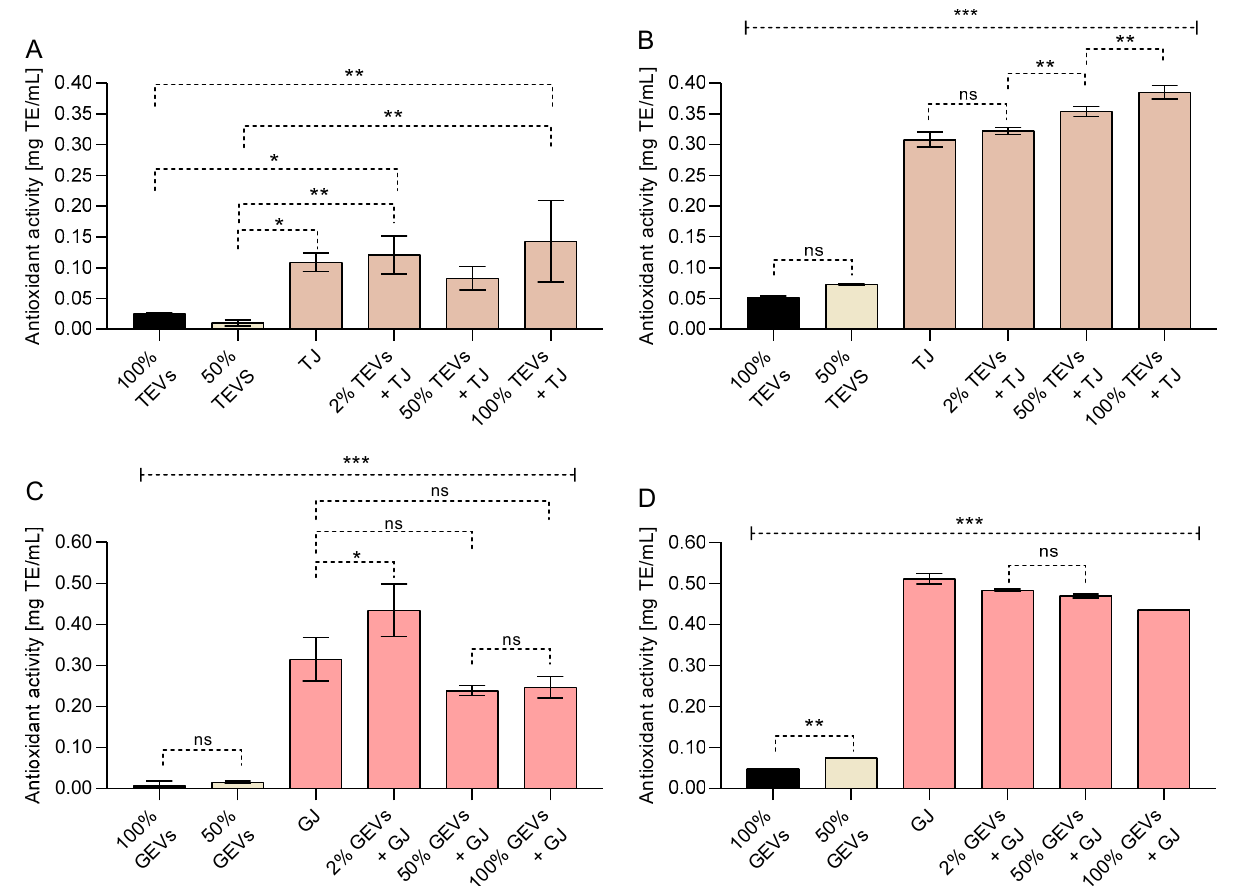
Figure 3. Antioxidant activity by ( A , C ) DPPH and ( B , D ) ABTS radicals assays of ( A , B ) tomato exosome vesicles (TEVs) and ( C , D ) grapefruit exosome vesicles (GEVs). Overall, pure GEVs and TEVs showed a lower antioxidant activity than tomato (TJ) and grapefruit juices (GJ) (*** p < 0.001, ** p < 0.01, * p < 0.05, ns p > 0.05; One-way ANOVA with Tukey’s post hoc test, n = 3). Results are expressed as mg of Trolox equivalent (TE) per mL of sample ± standard deviation (SD). SD < 0.01 were not plotted.